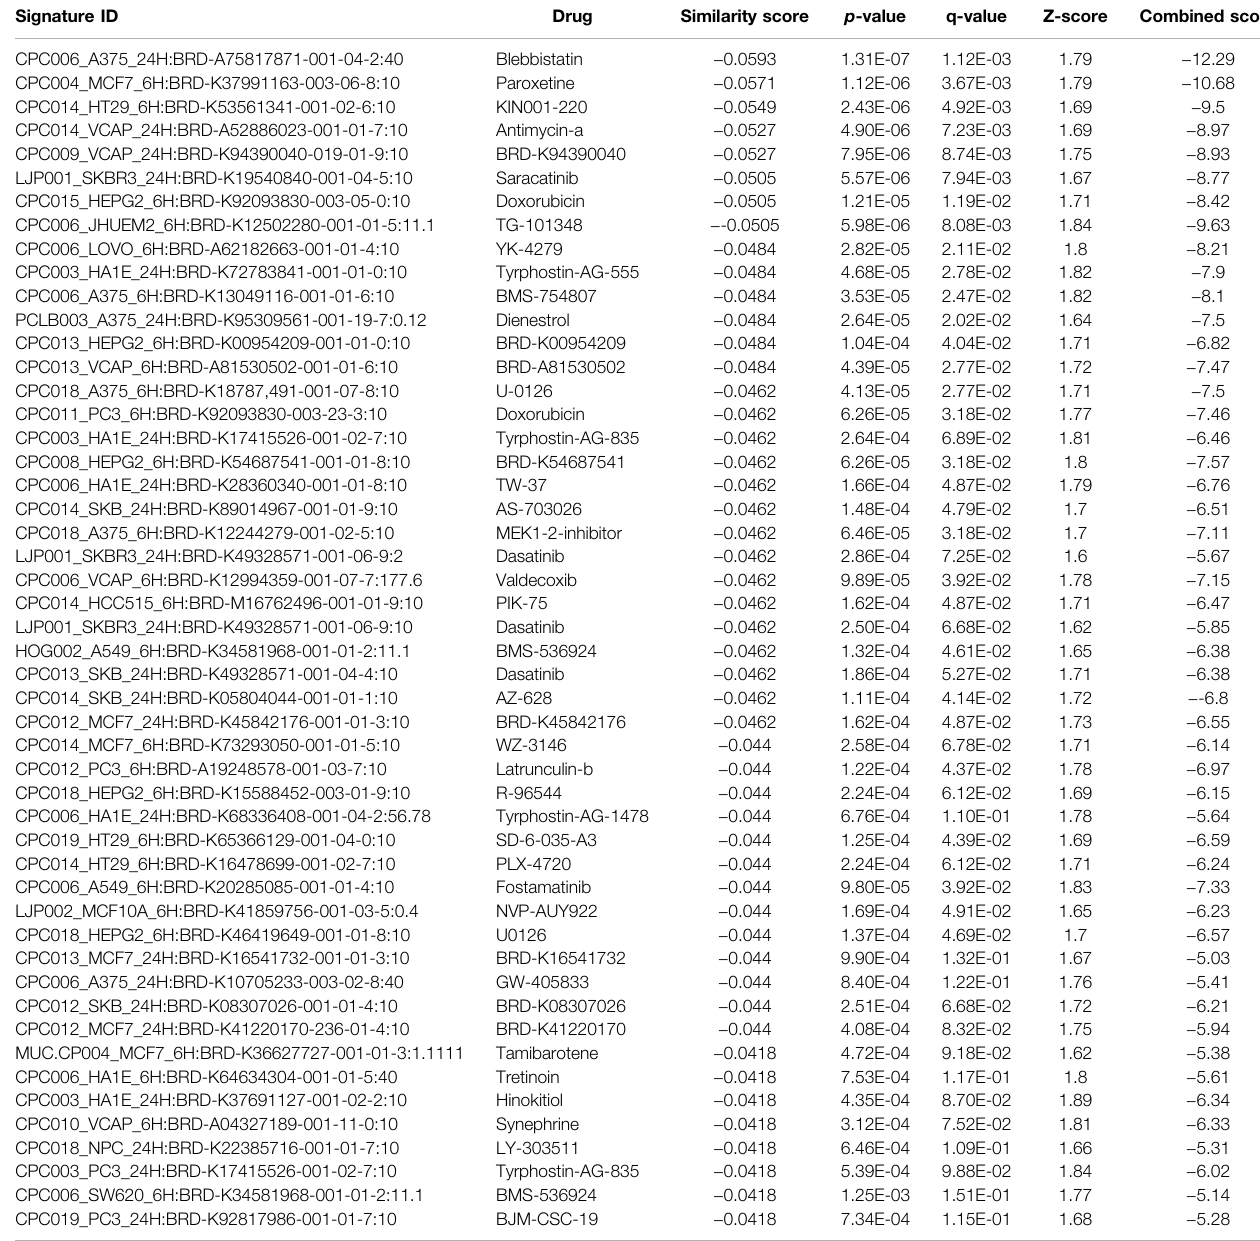
TABLE 10 | The top 50 drugs or natural products that reverse DEGs of astrocytes from entorhinal cortex in AD (AD00206 (disease) vs AD00201 (control) based on L1000FWD analysis. Signature ID